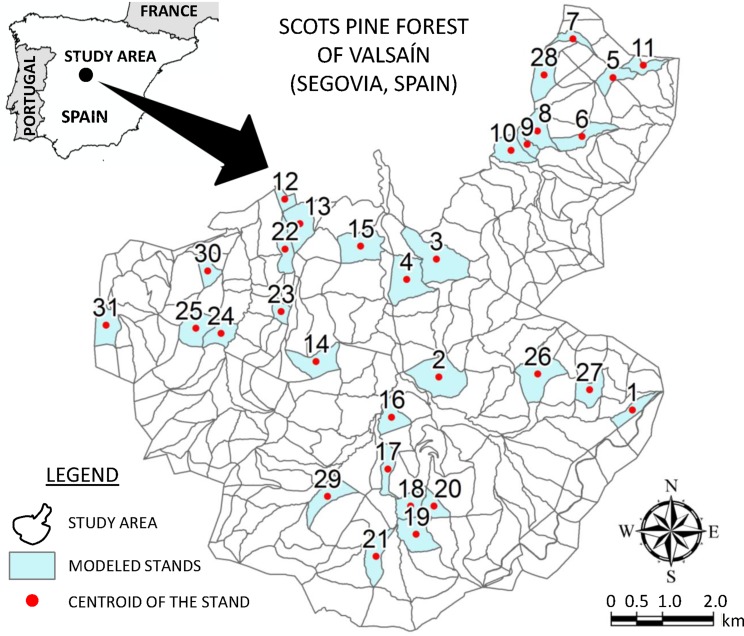
Study area location.